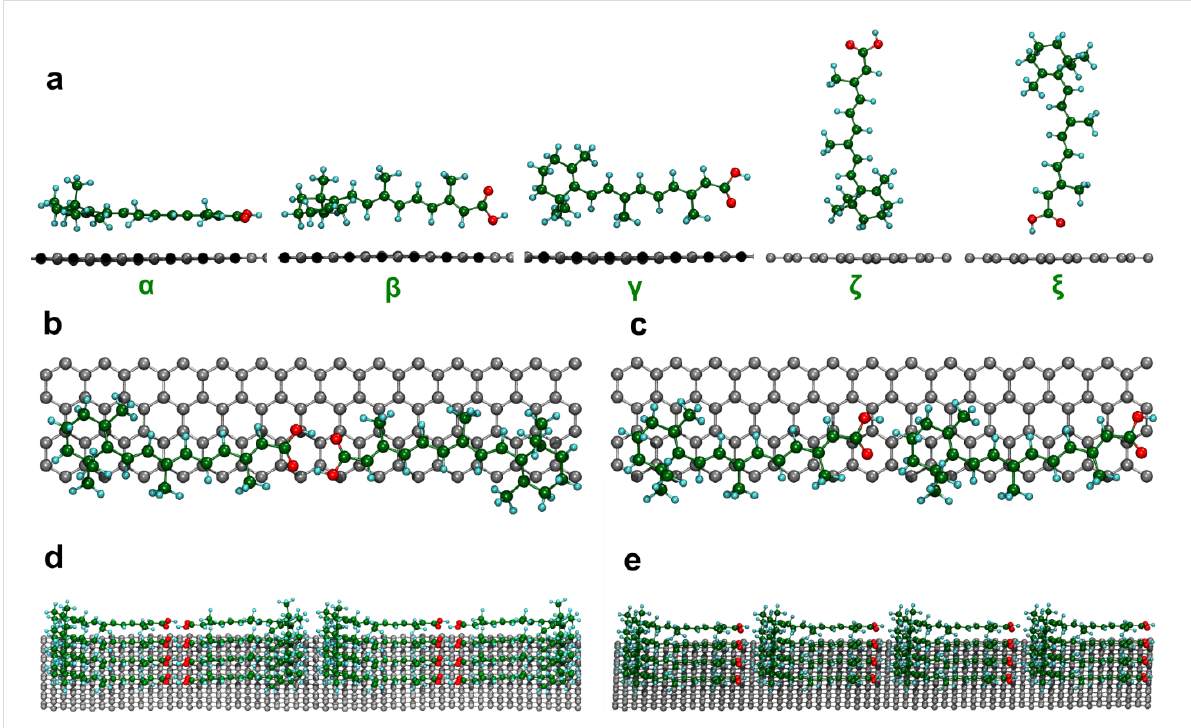
Figure 2: Calculated structures of the RA/graphene hybrid system. (a) Five different unit cell configurations of the RA/graphene system. (b)-(c) Top and (d)-(e) lateral views of the most stable molecular configuration α with two possible pair structures along the chain axis: tail–tail (b) and (d) and tail–head (c) and (e)